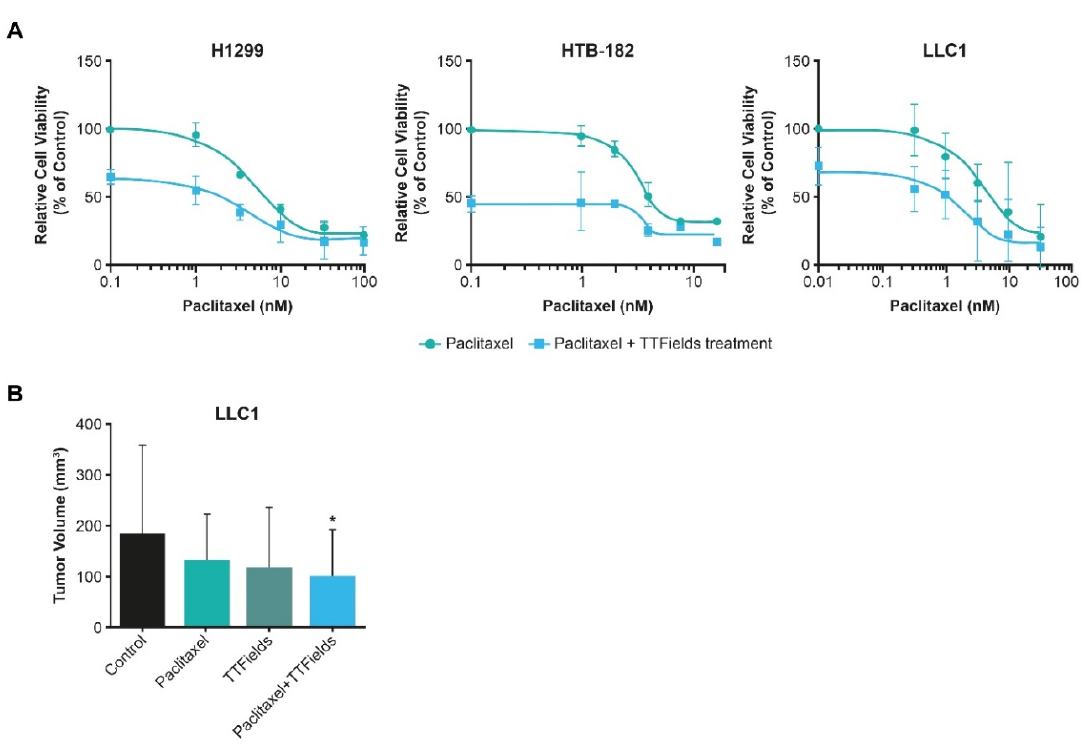
Figure 3. The effect of the TTFields treatment concomitant with paclitaxel on ( A ) cell viability in vitro on 2 human (H1299 and HTB ‐ 182) and 1 mouse (LLC1) cell line(s), and ( B ) tumor volume in vivo on the LLC1 mouse model. * p < 0.05 vs. control group. H1299 and HTB ‐ 182: human cell lines; LLC1: murine lung cancer cell line; TTFields: Tumor Treating Fields. Reproduced from Giladi M et al. Alternating Electric Fields (Tumor ‐ Treating Fields Therapy) Can Improve Chemotherapy Treatment Efficacy in Non ‐ Small Cell Lung Cancer Both In Vitro and In Vivo . Semin Oncol . 2014; 41 (Suppl. 6), S35–S41 with permission from Elsevier.